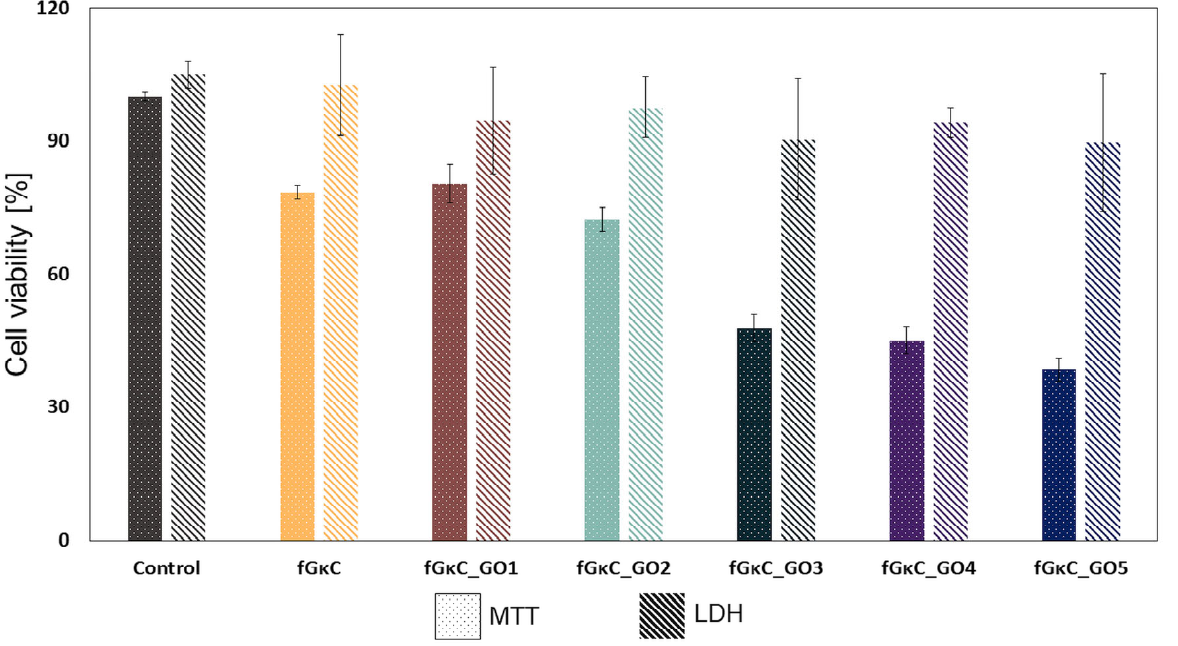
Figure 7. MC3T3-E1 cells viability after the exposure for 24 h to 12.5% extract of the fG κ C, fG κ C_GO1, fG κ C_GO2, fG κ C_GO3, fG κ C_GO4 and fG κ C_GO5 composite blends with 0, 0.009, 0.022, 0.063, 0.115 and 0.267 mg of GO.